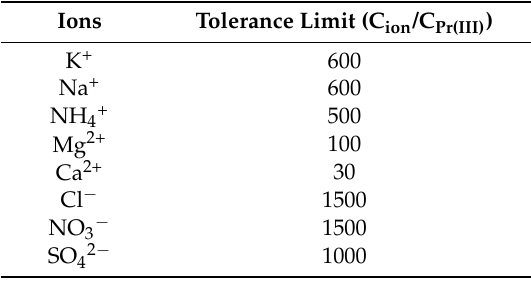
Table 3. Tolerance limits of some ions for praseodymium(III) sorption from aqueous solution